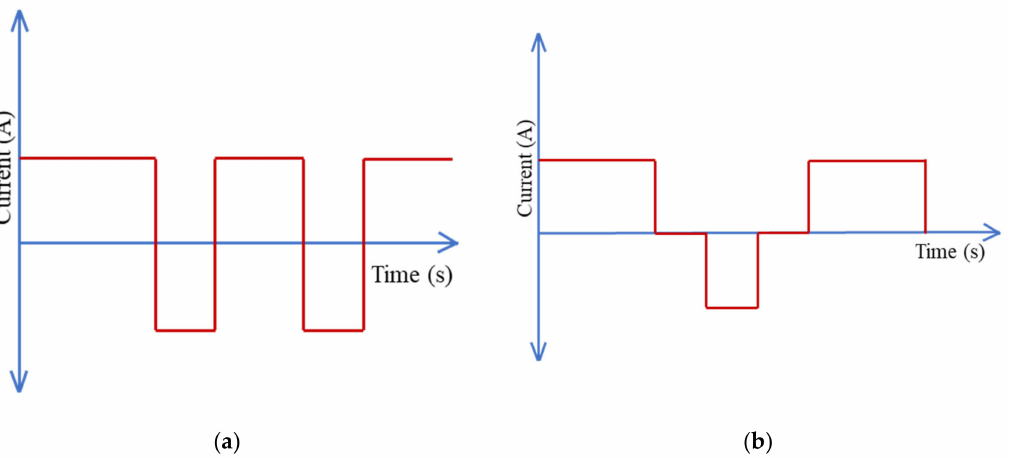
Figure 9. Different types of the ideal bidirectional pulsed charging current (BPCC) where ( a ) the standard normal operation, and ( b ) Operation while having a relaxing interval time between the positive and negative